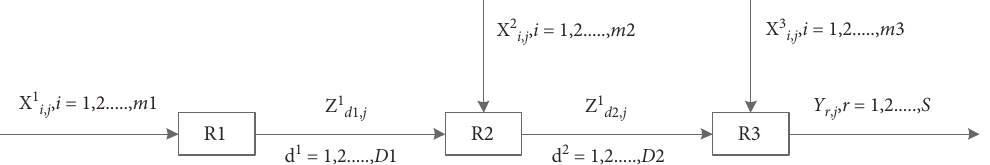
Figure 2: DEA model of three-stage chain network with additional